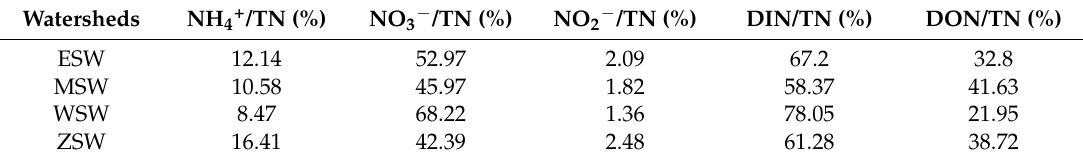
Table 2. Ratios between NH ₄ + / ‐ N, NO 3 − ‐ N, NO 2 − ‐ N, DIN, DON and TN in different sub ‐ watersheds.